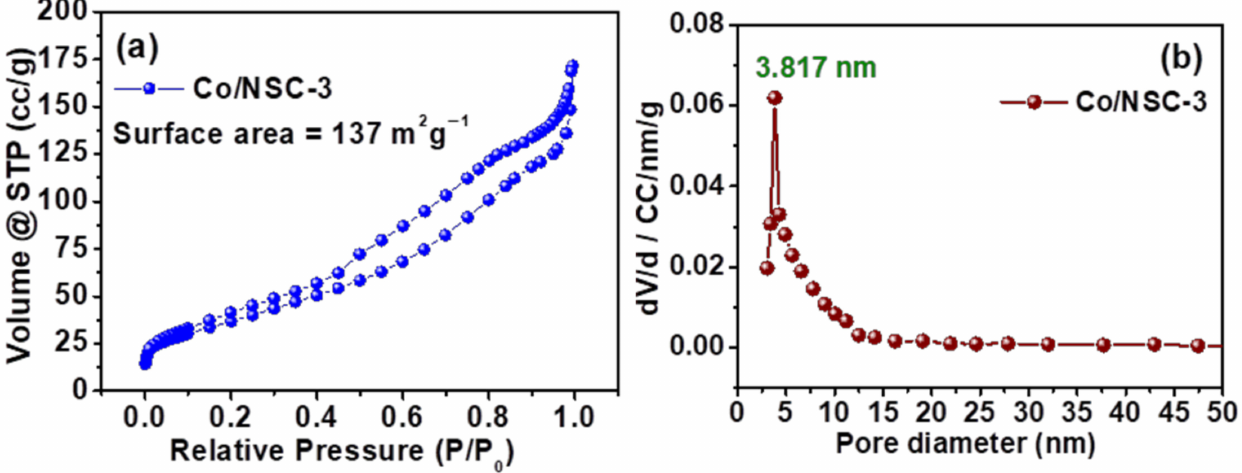
Figure 5. ( a ) N 2 adsorption/desorption isotherm curves of Co/NSC-3 and ( b ) pore size distribution curves of Co/NSC-3